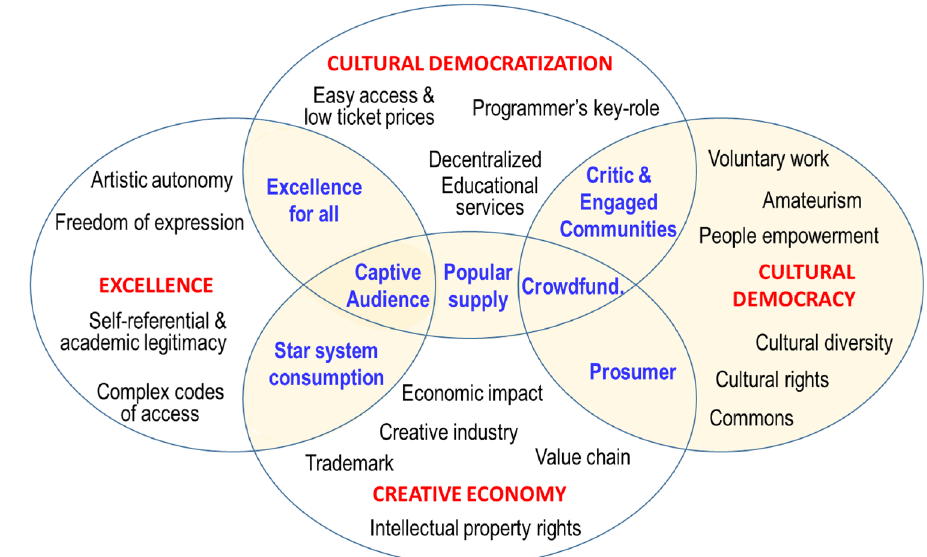
Fig. 1 Participation in cultural policy paradigms. Source: Bonet & Négrier,